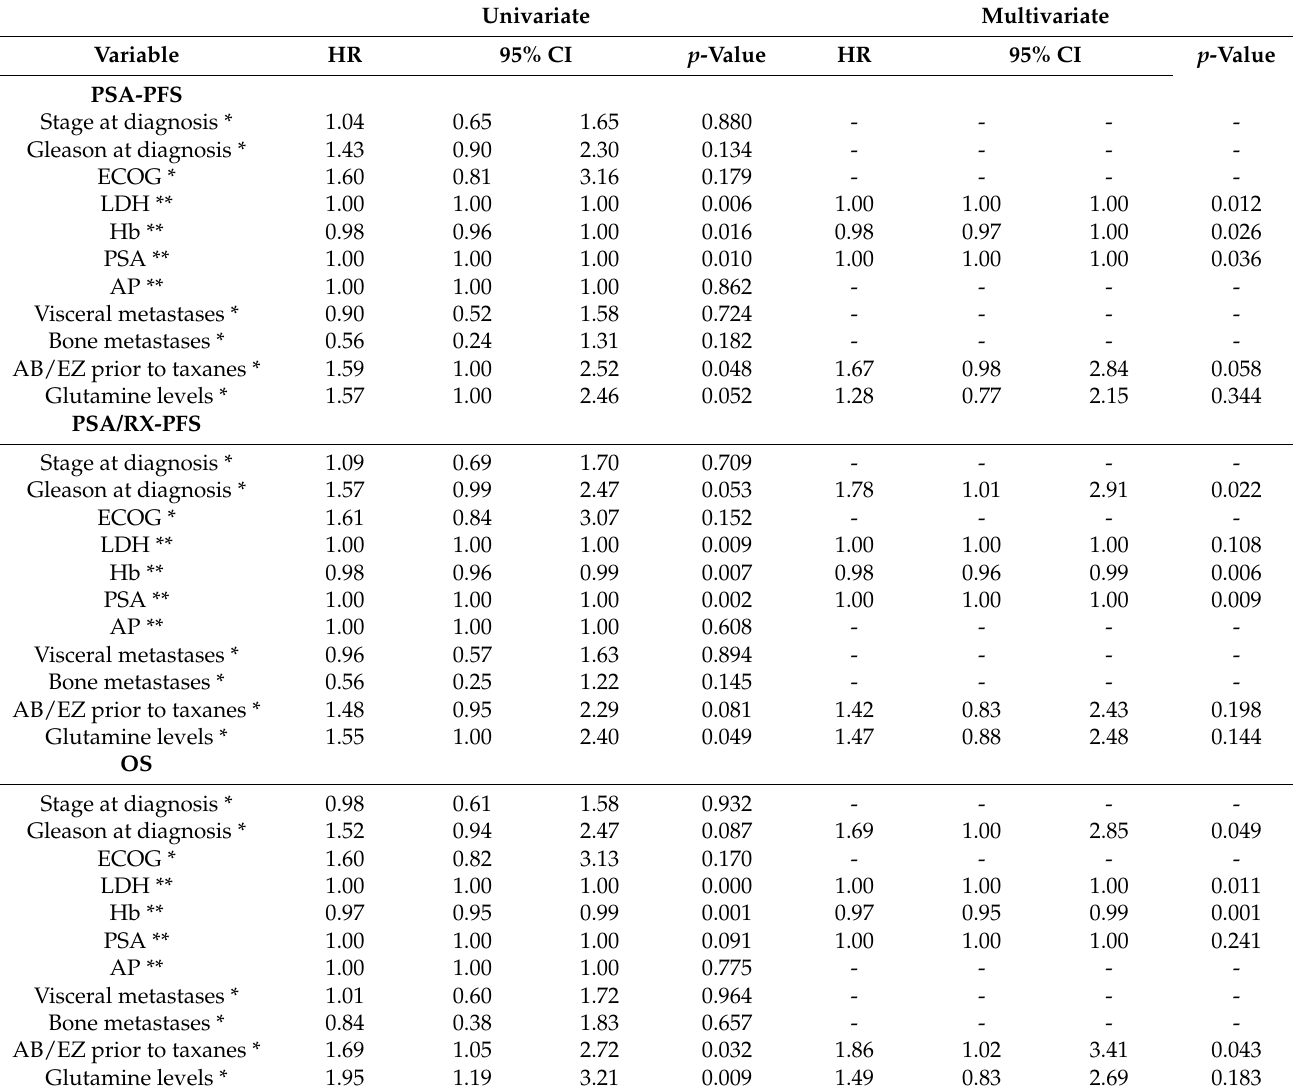
Table 2. Univariate and multivariate Cox model for PSA-PFS, PSA/RX-PFS and OS in patients from the plasma samples cohort adjusted for clinically significant variables ( p < 0.1) in the univariate analysis. Univariate